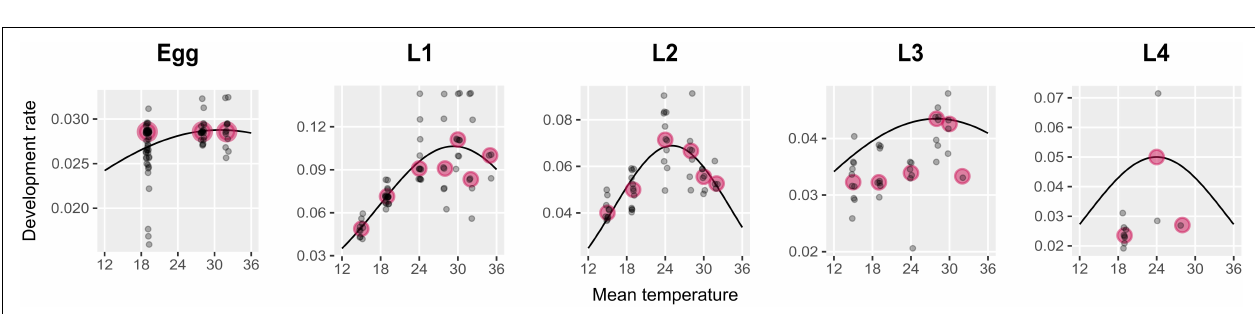
FIGURE 4 | Number of dead larvae and moltings over time, for each stage and thermal treatment. Dashed green and red vertical lines represent the median development times and mortality of each stage, respectively. Percentages (N) of dead (red) and molted larvae (green) are detailed for each panel. In T15 and T32, the experiment was stopped after all individuals completed L3 because of urtication and contamination risks associated with next stages could not be mitigated in the corresponding laboratory. Twenty-one L2 and six L3 were subsampled in T19 for another experiment and are therefore discarded.